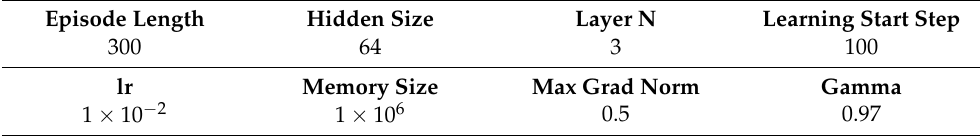
Table A2. DDPG parameter setting.